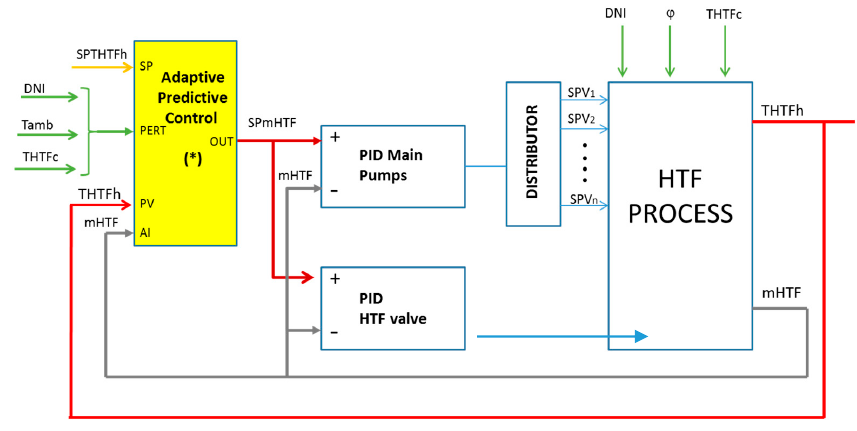
Figure 6. HTF heating process with the adaptive–predictive–expert control (ADEX) controller.